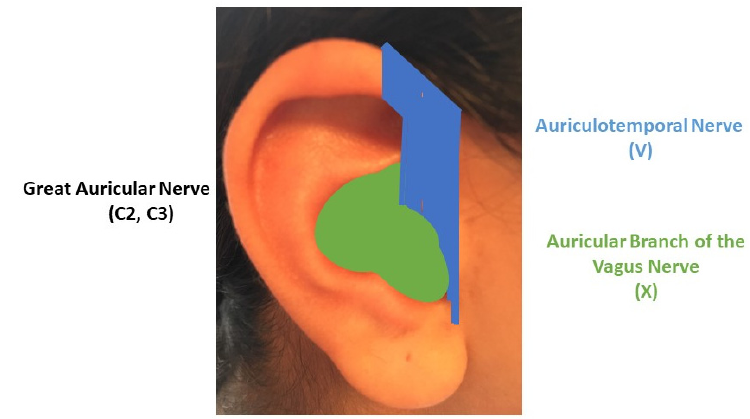
Figure 2. Delineation of three strategic areas for non ‐ invasive neuromodulation on the lateral side of the auricle: the green area is mainly supplied by the Auricular Branch of the Vagus Nerve (X); the blue area is mainly supplied by the Auriculotemopral nerve, a branch of the trigeminal nerve (V); the largest remaining area is mainly supplied by the Great Auricular Nerve (C2, C3). Inspired by Peuker and Filler, 2002. Copyright Dr. Rangon.